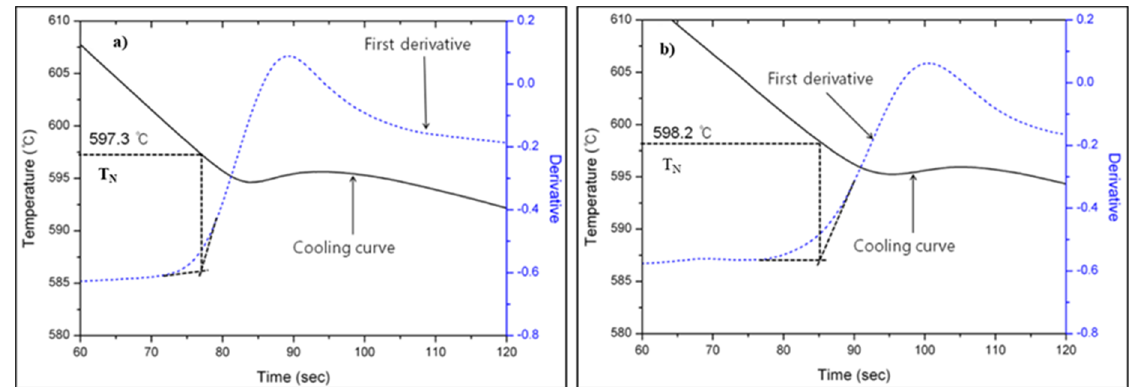
Figure 12. ( a ) T N of the cooling curve of ( a ) the CP AZ91 alloy and ( b ) the CP AZ91 alloy with 0.5 wt.% Al–Mn master alloy ribbons.